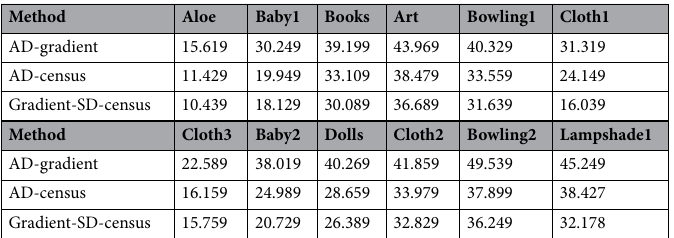
Table 3. Mismatching rate of all pixel disparity for different cost computation methods(%).